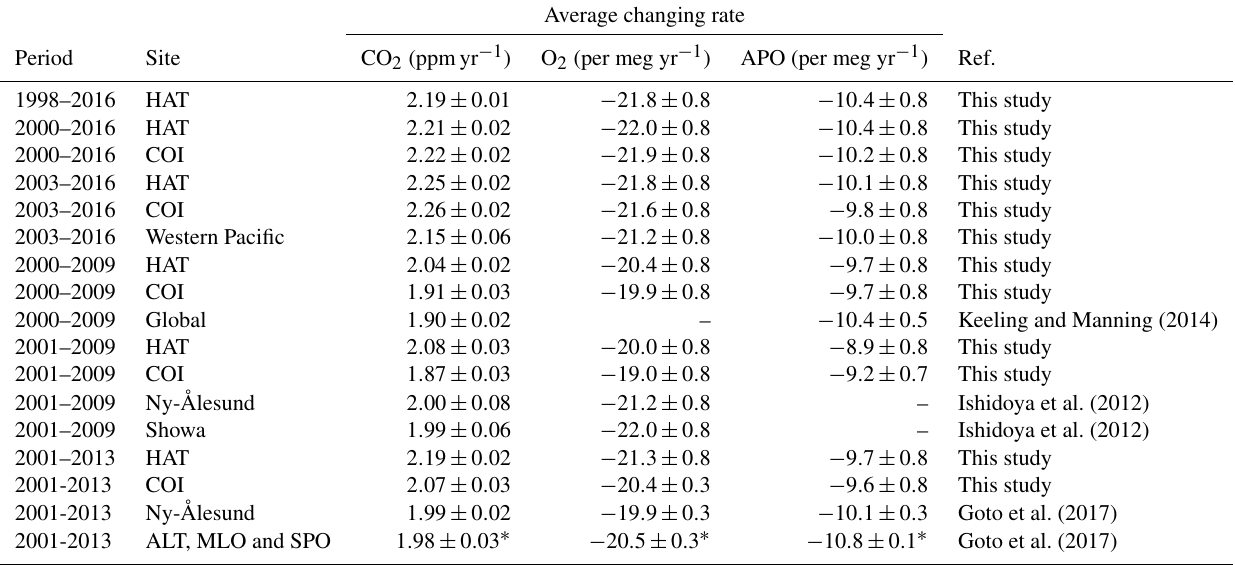
Average changing rate